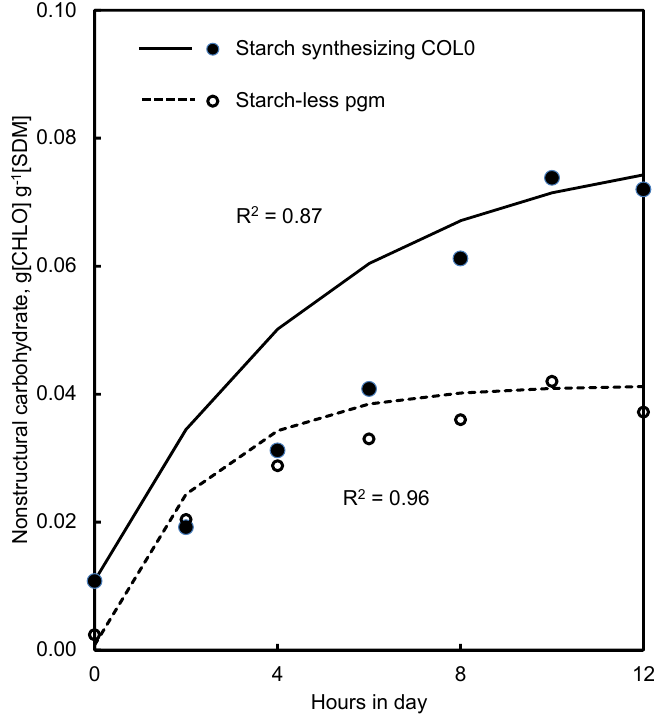
Figure 6. Non ‐ structural carbohydrate in starch synthesizing, COL0 , or starch ‐ less, pgm , mutants of Figure 6. Non-structural carbohydrate in starch synthesizing, COL0 , or starch-less, pgm , mutants of Arabidopsis under a 12 ‐ h day length [31] and predictions of the dynamic model. Symbols are data Arabidopsis under a 12-h day length [31] and predictions of the dynamic model. Symbols are data and and lines are predictions. lines are